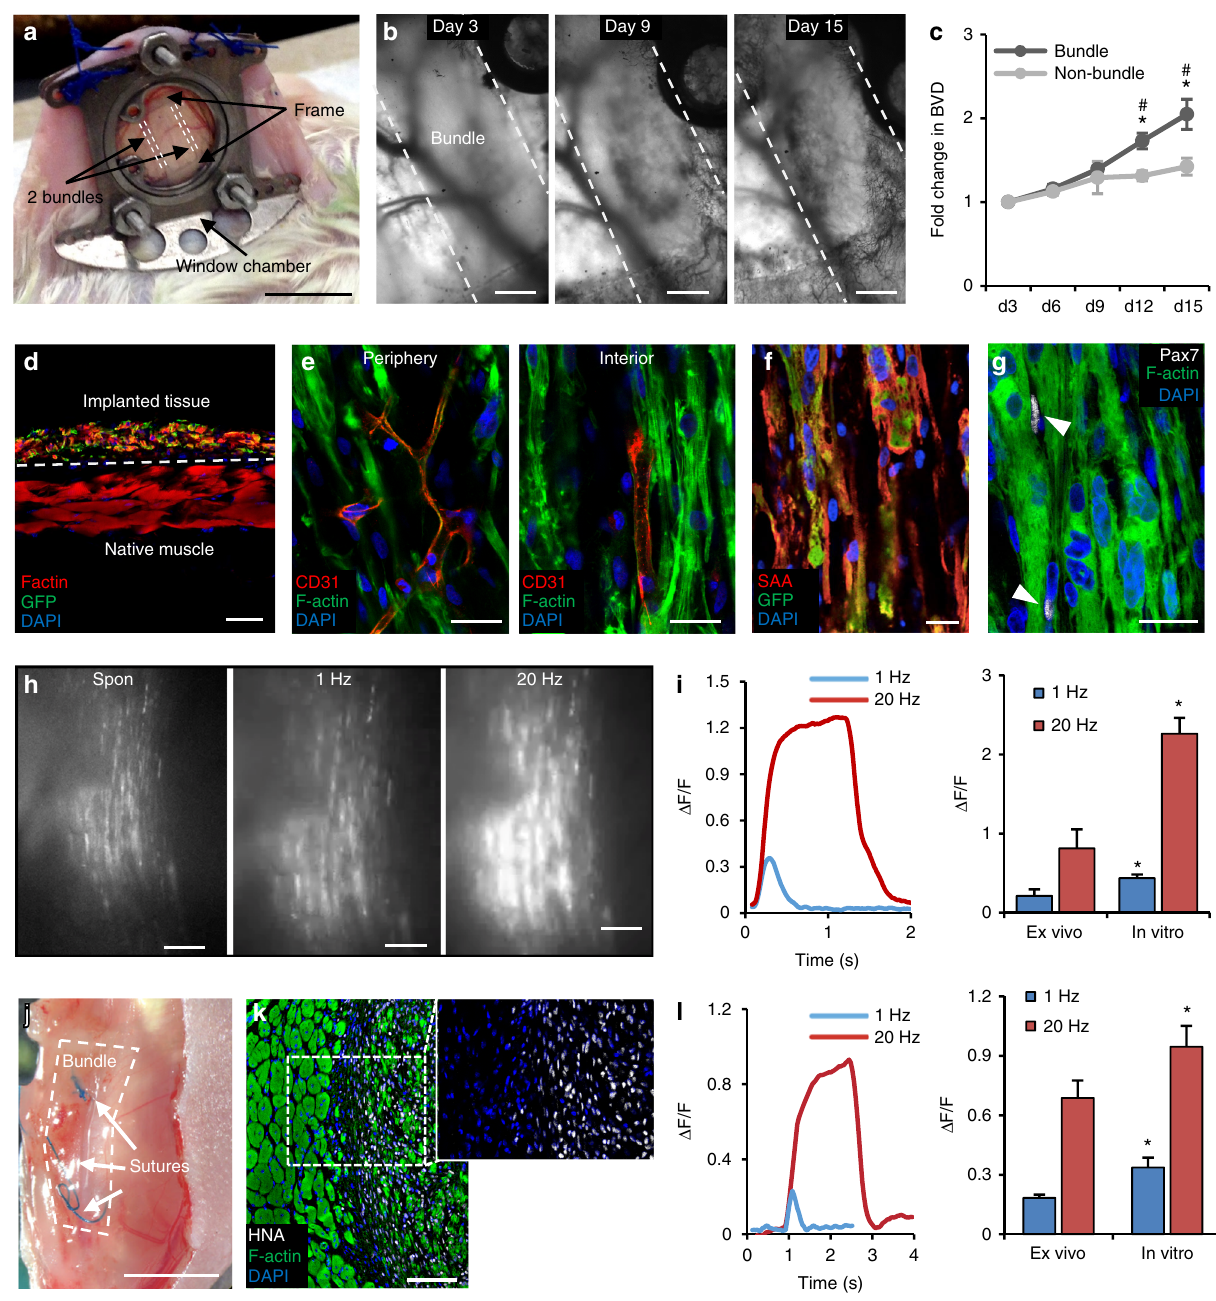
Fig. 6 Engraftment and function of iSKM bundles implanted in immunode fi cient mice. a Implanted bundles (delineated by dashed lines) within the dorsal skin-fold window chamber. Scale bar = 5 mm. b Representative images showing progressive ingrowth of host blood vessels in implanted iSKM bundles at day 3, 9, and 15 post-implantation, PI. Scale bar = 200 µ m. c Relative fold change in blood vessel density (BVD) with time PI in bundle and non-bundle areas ( n = 16 bundles (2 differentiations) from 12 mice (6-10wk); *P < 0.0001 vs. day 3, # P < 0.0001 vs. non-bundle area, Tukey – Kramer HSD test, data are presented as mean ± SEM). d Representative cross-section of implanted bundle with GFP-positive myo fi bers and underlying host skin muscle. Scale bar = 50 µ m. e Vessel organization at the periphery and interior of implanted bundle with endothelial cells labeled by CD31. Scale bar, 25 µ m. f Representative staining of implanted bundle showing aligned myo fi bers positive for sacromeric α -actinin, SAA. Scale bar = 25 µ m. g Pax7 + satellite cells (arrowheads) are found adjacent to myotubes within implanted bundles. Scale bar = 25 µ m. h Representative images of GCaMP6 signals from implanted bundles recorded ex vivo without (spontaneous) or during 1 Hz and 20 Hz electrical stimulation at 15 days PI. Scale bar = 200 µ m. i Representative traces (left) of ex vivo recorded GCaMP6 Ca 2+ transients during 1 Hz and 20 Hz stimulation of 15 day PI bundles and corresponding amplitudes (right) compared to age-matched in vitro cultured bundles (* P < 0.05 vs. ex vivo, Tukey – Kramer HSD test; n = 18 bundles from 10 mice for ex vivo and 6 bundles for in vitro group, data are presented as mean ± SEM). j iSKM bundles implanted into mouse TA muscle. Scale bar = 5 mm. k Representative TA muscle cross-section showing 1-week implanted iSKM bundle labeled with human nuclear antigen (HNA). Scale bar = 200 µ m. l Representative traces (left) and amplitudes (right) of ex vivo recorded R-GECO Ca 2+ transients during 1 Hz and 20 Hz stimulation of iSKM bundles implanted in TA muscle and age matched in vitro controls (* P < 0.05 vs. ex vivo, Tukey – Kramer HSD test; n = 8 bundles from 8 mice (6 – 8wk) for Ex vivo and 6 bundles for in vitro group, data are presented as mean ±